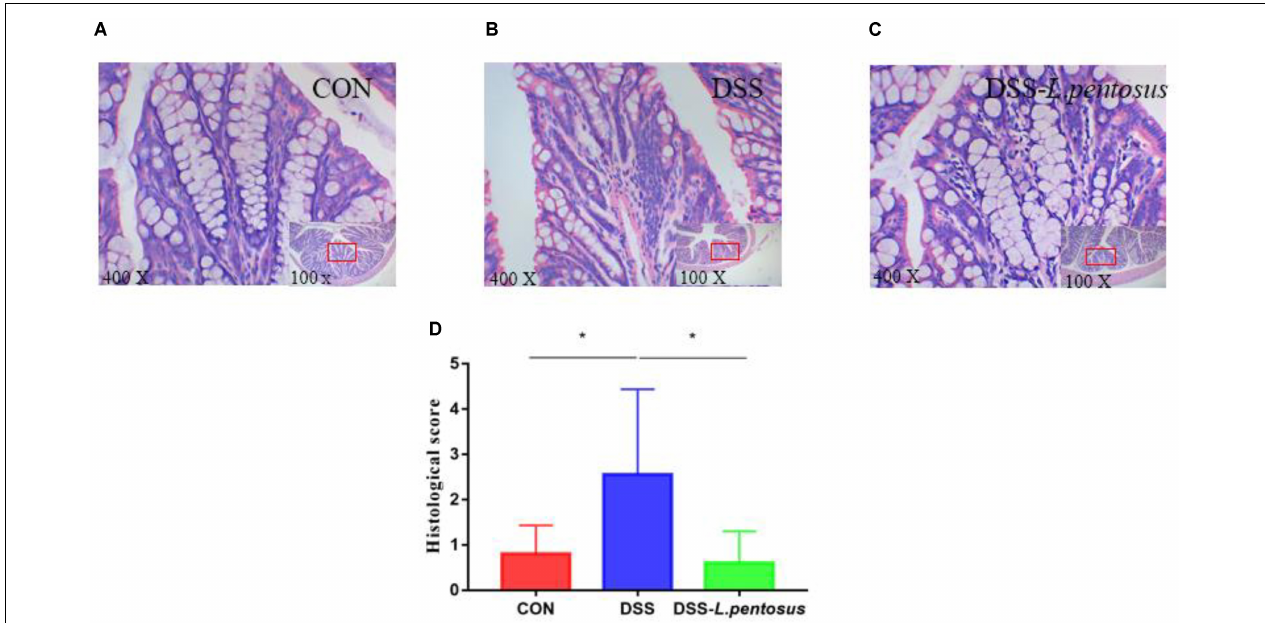
FIGURE 2 | The therapeutic effect of intragastric administration of Lactobacillus pentosus on colon tissue damage. Images of colon morphology in the CON (A) , DSS (B) , and DSS- L . pentosus (C) groups under 100 × and 400 × visual fields; (D) Histomorphological damage scores in the three groups. Data are mean ± SD ( n = 8) and analyzed by one-way ANOVA. * p <